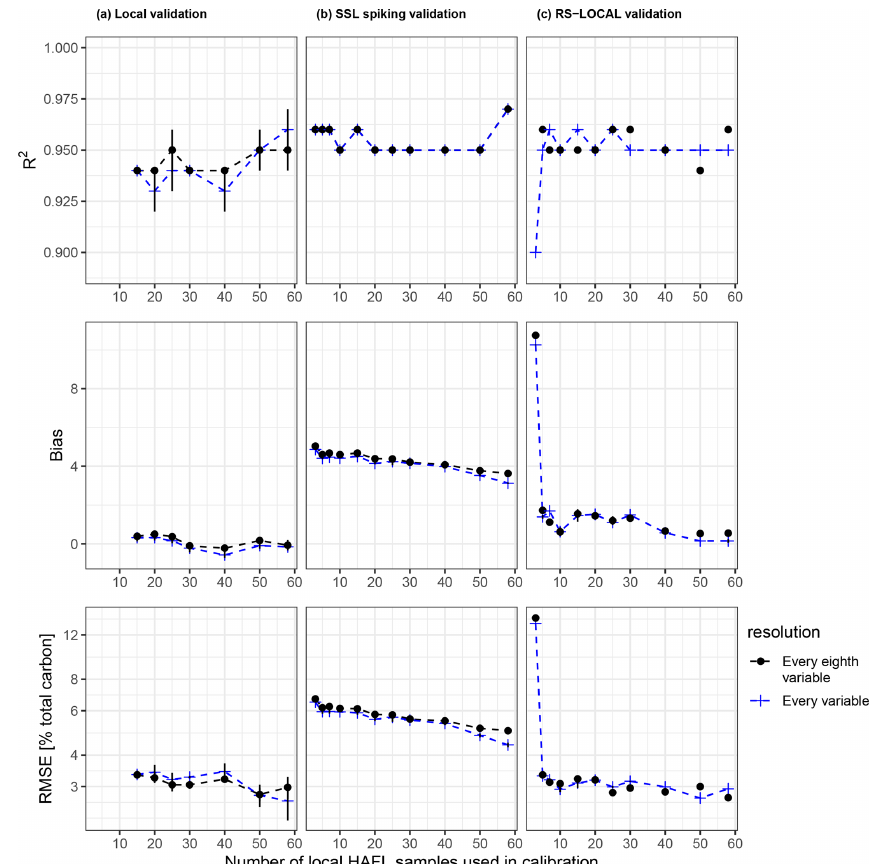
Figure A1. R 2 , bias and RMSE values in percent total carbon (RMSE in logarithmic scale) of model validations vs. the number of local HAFL samples used in local HAFL (a) , local combined with SSL (b) and RS-LOCAL subsets of the SSL (c) , where k = 300 . These validation metrics are shown for models using all spectral variables as opposed to only every eighth variable, which is a preprocessing